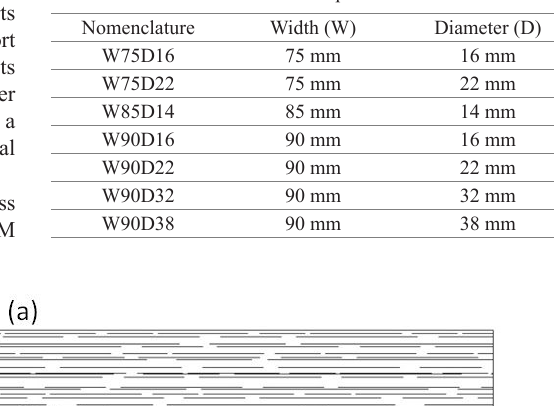
Table 1. Nomenclature used to